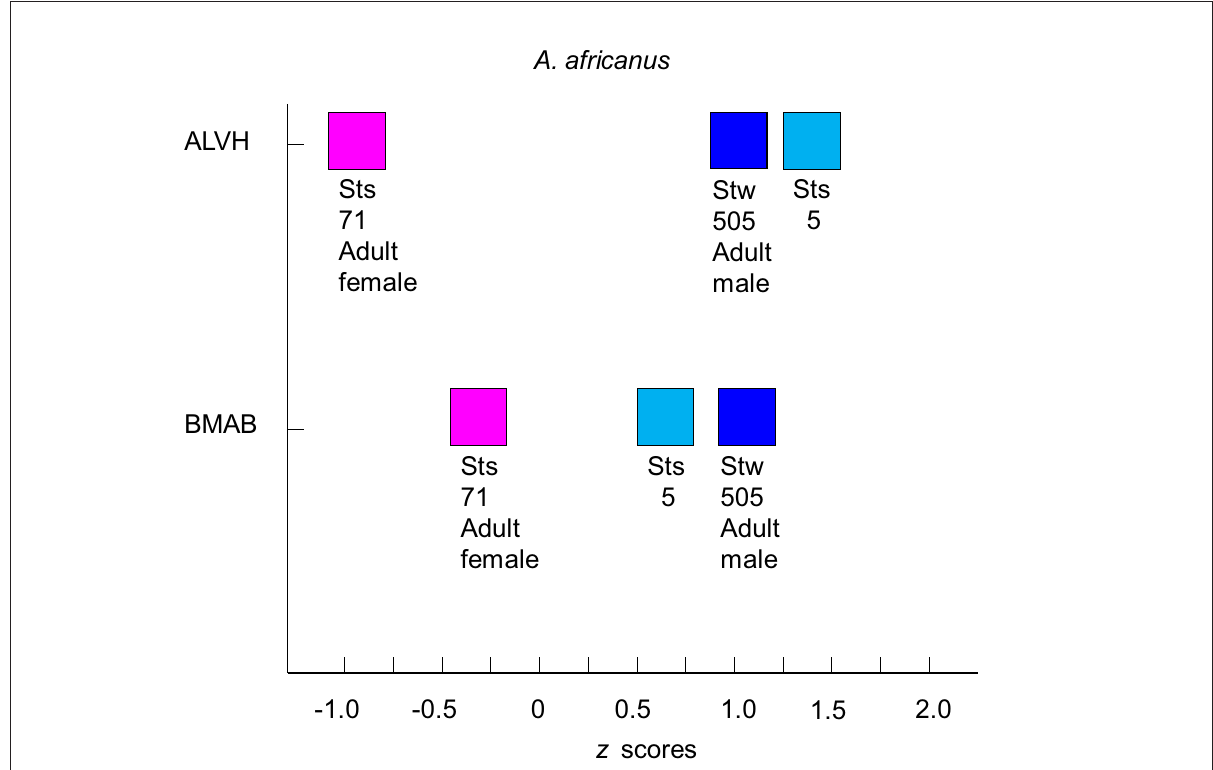
Figure 2: Standardised z -values for Sts 5, compared to other specimens of Australopithecus africanus, based on means and standard deviations of alveolar height (ALVH) and bi-maxillary breadth